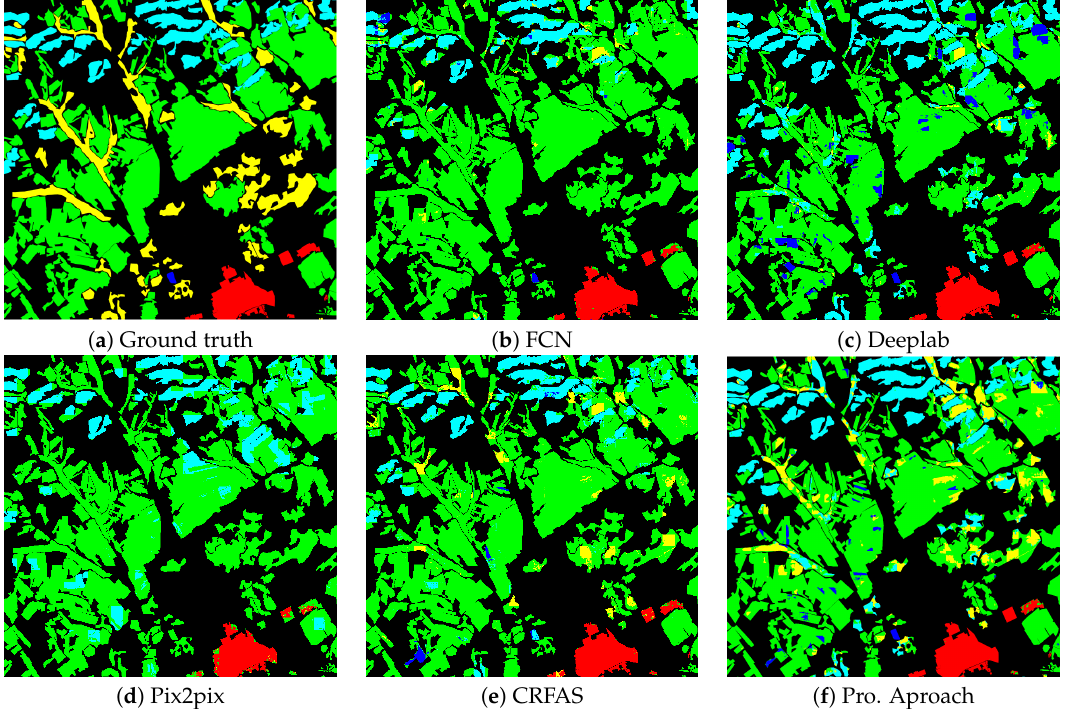
Figure 10. Segmentation results of GID-image1. ( a ) The ground truth; ( b – d ) the results by FCN, Deeplab, and Pix2pix, respectively; ( e , f ) the results by CRFAS and the proposed